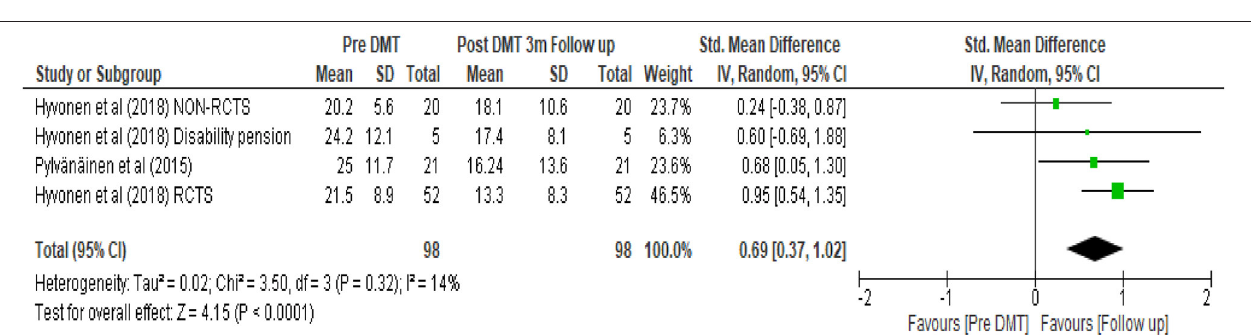
FIGURE 6 | Within DMT groups (pre DMT vs. post DMT).